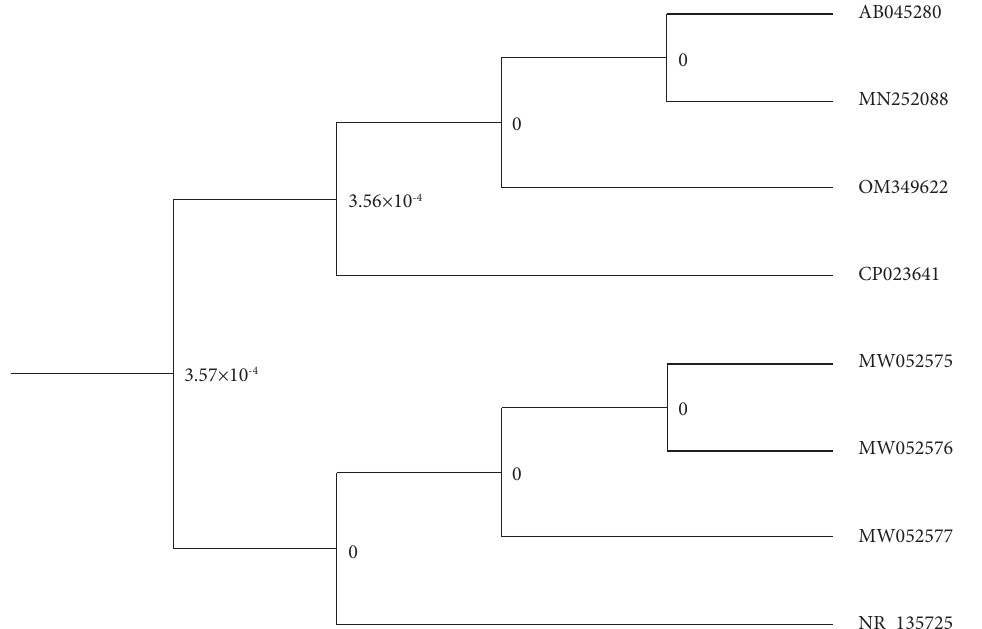
Figure 4: Phylogenic tree of P. guguanensis strain Iraqi ZG.K.M in NCBI database.